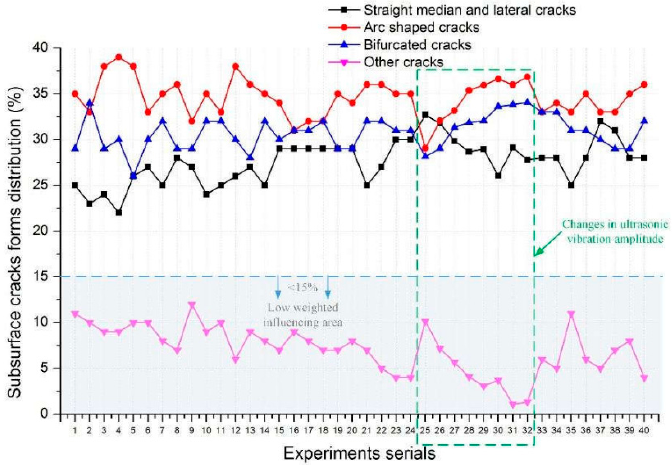
Figure 5. Proportions of subsurface cracks.